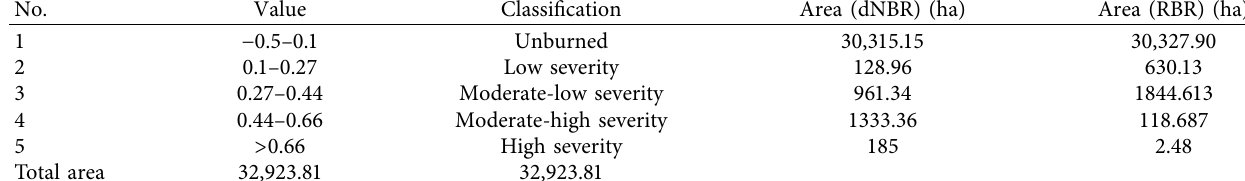
Table 3: Severity classification of the burned areas based on the dNBR and RBR transformation in Banjarbaru.